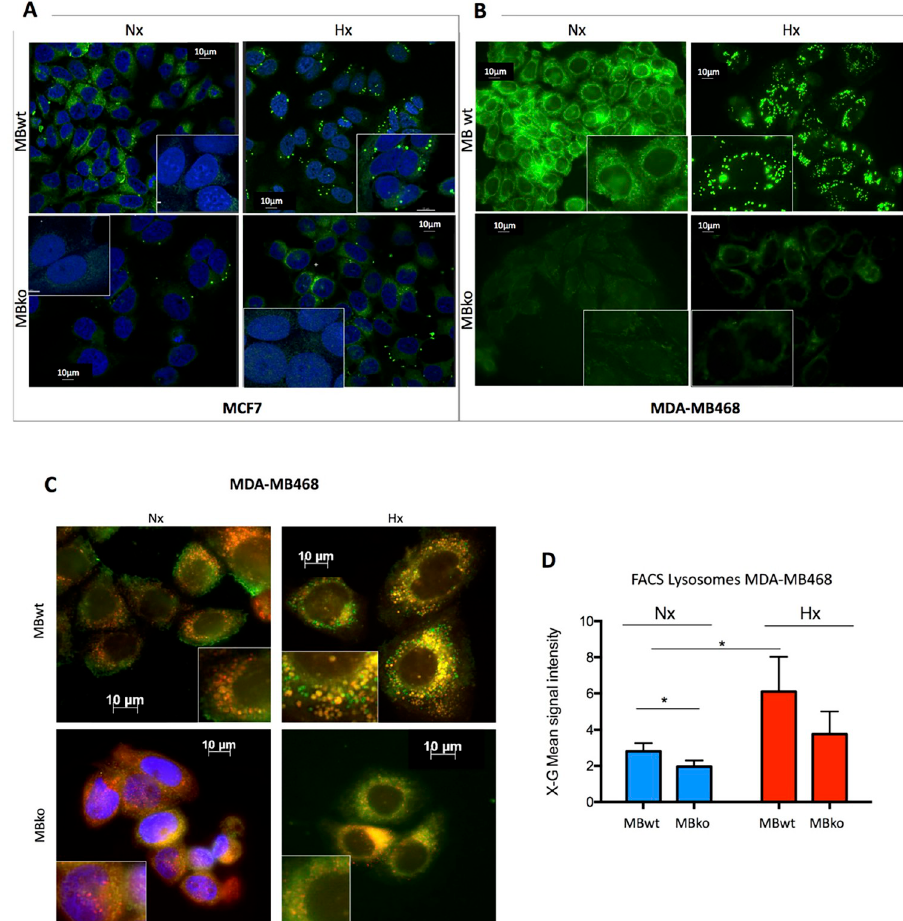
Fig 4. MB-based trafficking of fatty acids. MB in MCF7 ( A ) and MDA-MB468 ( B ) cells controls the transport of a fluorogenic palmitate derivative (BODIPY-FL C16) between cytoplasm and vesicular depots in an O 2 -dependent fashion. Cells were incubated with BODIPY (green) for 30 min before exposure for 72 hrs to normoxia (Nx, air, oxygenated MB) or severe hypoxia (Hx, 0.2% O 2 , deoxygenated MB). The nuclei of MCF7 cells were stained with DAPI (blue). The figures shown are the representative of 6 independent experiments. Scale bar: 10 μ m. Magnification: 63x. ( C) MBwt and MBko MDA-MB468 cells incubated under normoxia (Nx) or severe hypoxia (Hx) were co-stained with BODIPY and a lysosome marker (Cytopainter red). The figures shown are representative of 3 independent experiments. Scale bar: 10 μ m. Magnification: 63x. MBko (Nx) cells were stained by DAPI for nuclei. ( D ) Lysosomal (Cytopainter red) staining in MDA-MB468 cells was analysed by FACS measurement with the signal intensity expressed as geometric mean (X-GMean). Students t-test was used for statistics (n = 5); mean ± SD. � p �